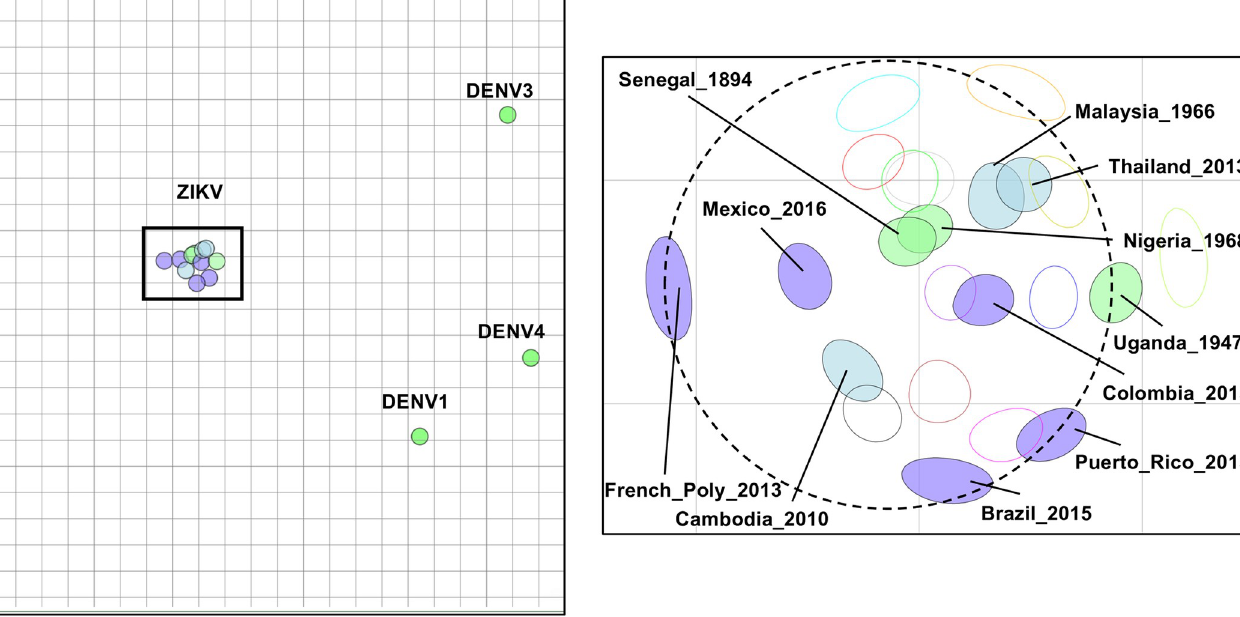
Fig 5. Antigenic map of eleven ZIKVs against twelve human ZIKV immune sera from 5 to 38 months post-infection. Locator map shows the relative antigenic relatedness between ZIKV and the dengue viruses. Each unit of antigenic distance (AU), the length of one side of a grid square, is equivalent to a two-fold dilution in the neutralization assay. Inset map shows each serum and ZIKV. Sera are shown as open blobs colored to match each serum as in Fig 2. Each virus is shown as a filled blob and is colored according to virus strain (American = slate blue, African = turquoise, Asian = steel blue ). The size and shape of each blob is the confidence area of its position. Dashed line circle has a diameter equal to 2 AU or four-fold, the difference of a single dilution in the FRNT assay used to estimate FRNT 50 titer. https://doi.org/10.1371/journal.pntd.0008006.g005 PLOS NeglectedTropical Diseases | https://doi.org/10.1371/journal.pntd.0008006 April 13,